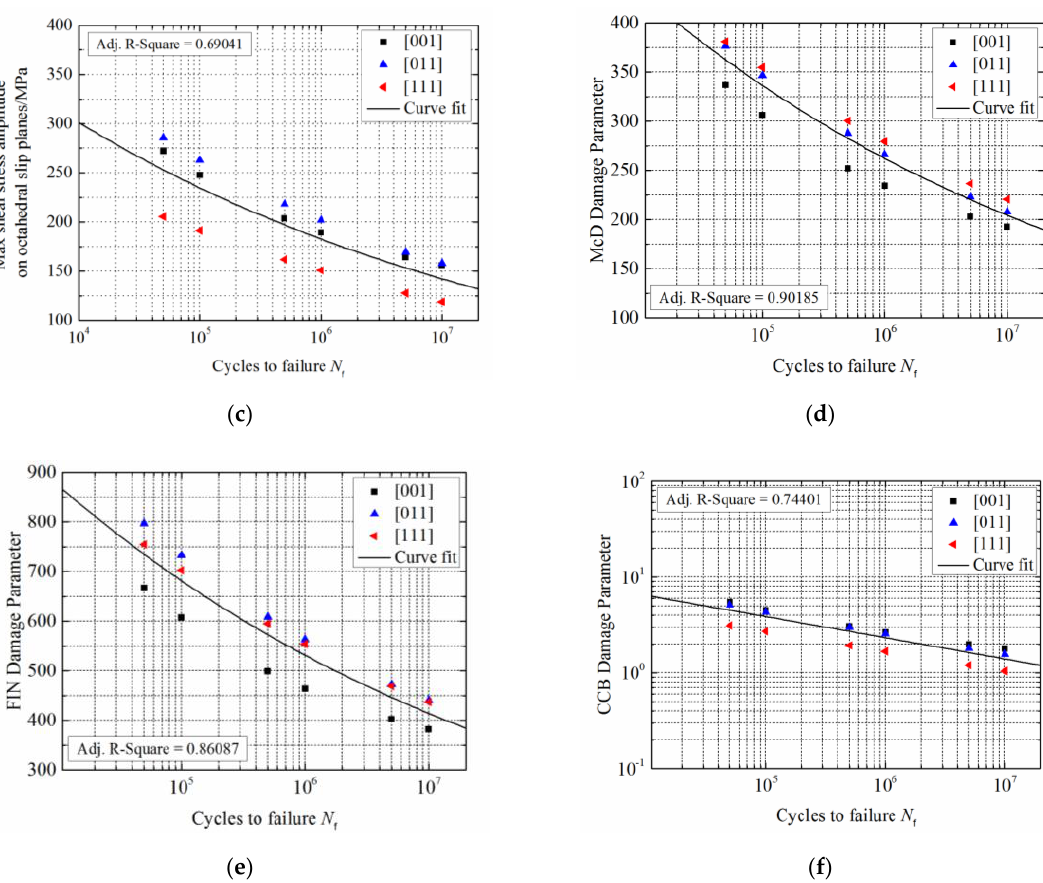
Figure 4. Fatigue life predictions for DD6 material at 800 °C: ( a ) stress amplitude; ( b ) maximum resolved shear stress amplitude; ( c ) maximum resolved shear stress amplitude (primary octahedral slip system); ( d ) McD model; ( e ) Fin model; ( f ) CCB model.